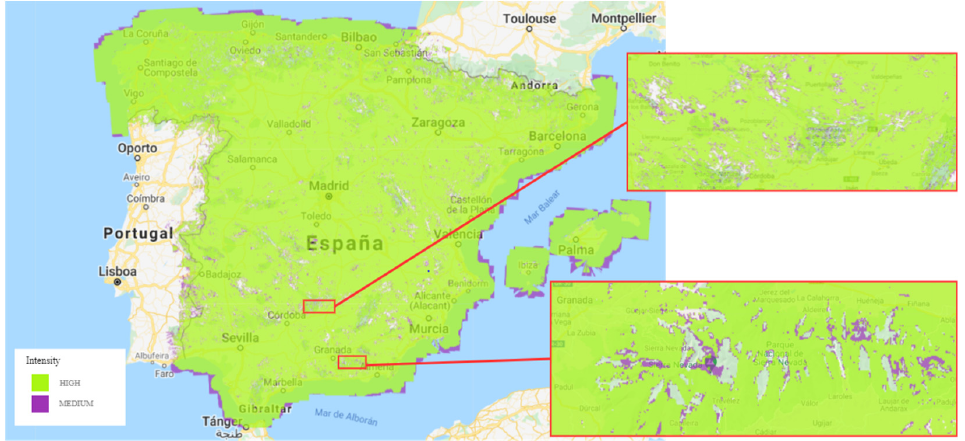
Figure 1. Areas without mobile coverage in “Sierra Morena” (Andujar) and “Sierra Nevada” (Granada). The green areas correspond to areas where the intensity of coverage is high, the purple areas correspond to areas of medium intensity, and the unmarked areas are shaded areas.